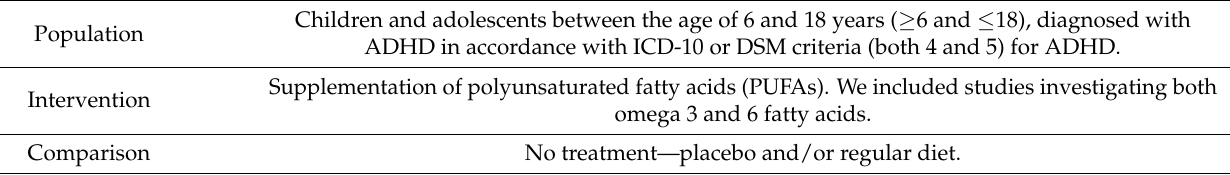
Table 1. Population, Intervention, Comparison, and Outcome (PICO) criteria for inclusion and exclusion of studies. Children and adolescents between the age of 6 and 18 years ( ≥ 6 and ≤ 18), diagnosed with Population ADHD in accordance with ICD-10 or DSM criteria (both 4 and 5) for ADHD.